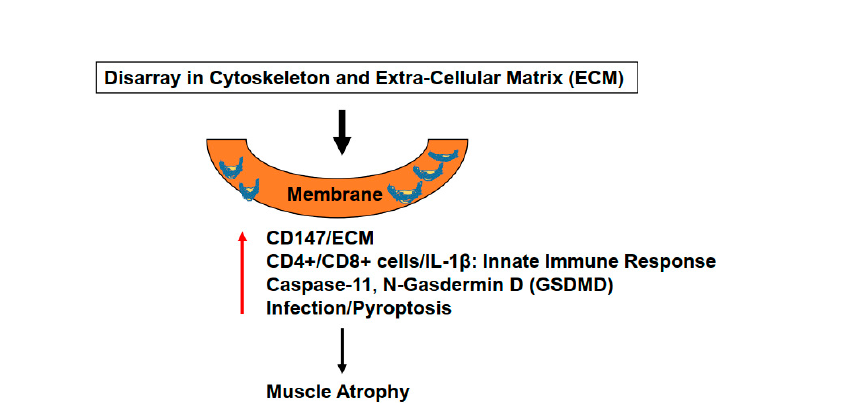
Figure 2. Mutation in the dystrophin protein causes derangements in the cytoskeletal leading to ECM remodeling causing activation of the innate immune system, severe inflammation, and lung injury.